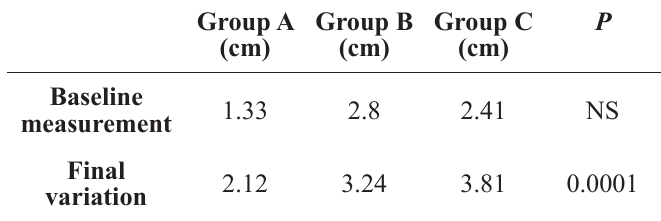
TABLE 5 - comparison between groups.